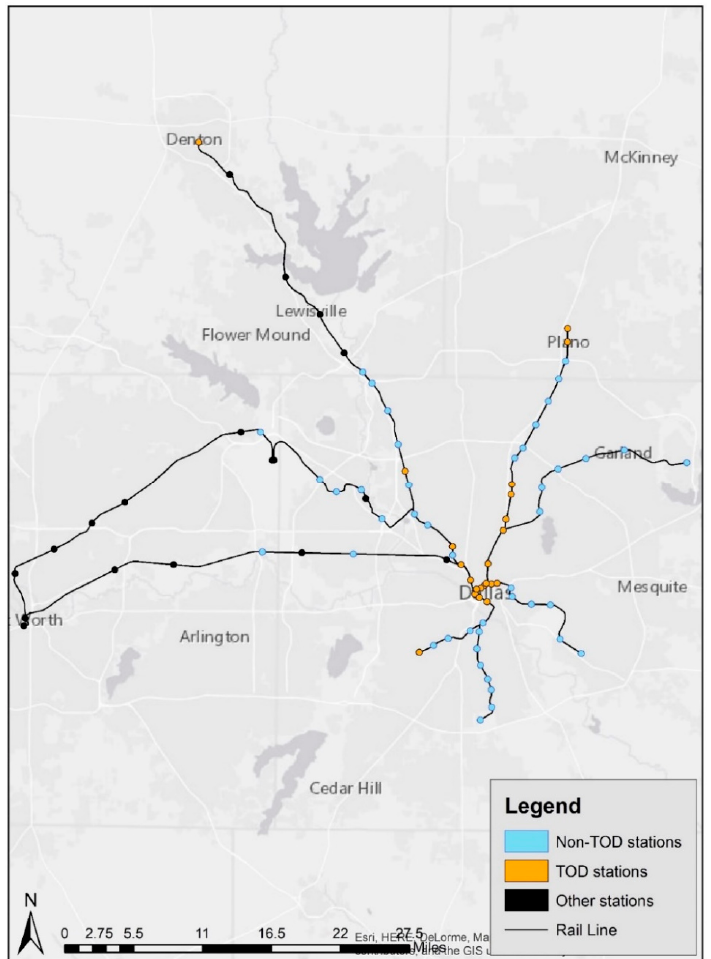
Figure 1. Study locations (Source: North Central Texas Council of Governments (NCTCOG), 2018).